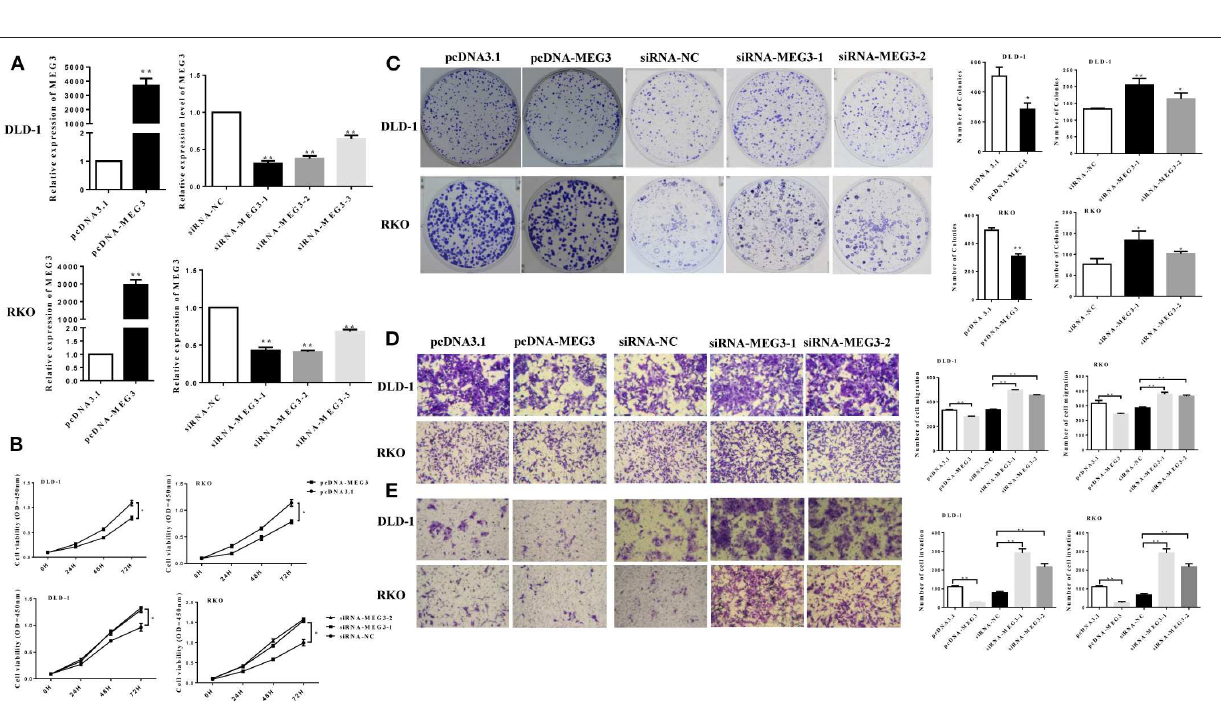
FIGURE 2 | Maternally expressed gene 3 ( MEG3 ) inhibits colorectal cancer (CRC) cell proliferation and invasion. (A) MEG3 expression as quantified by RT-qPCR in DLD-1 and RKO cells transfected with the indicated siRNAs or pcDNA-MEG3. (B) CCK-8 assays and (C) colony-forming growth assays were performed in DLD-1 and RKO cells transfected with MEG3 siRNAs or pcDNA-MEG3. Transwell assays were performed to detect the migration (D) and invasion (E) of MEG3 knockdown and overexpressing cells 36–48h after transfection. Data are expressed as mean ± standard deviation from three independent experiments. * P < 0.05, ** P <